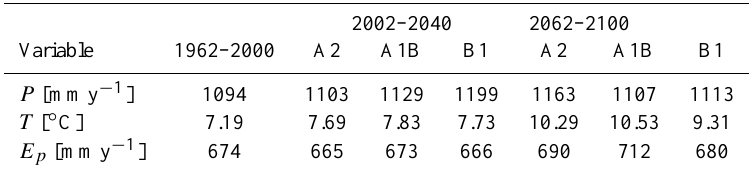
Table 1. Overview of average annual sums of precipitation ( P ) and potential evaporation ( E p ; derived using the method explained in Sect. 3.3), and average annual mean temperature ( T ), for the reference period and two 39-year periods in the 21st century according to three